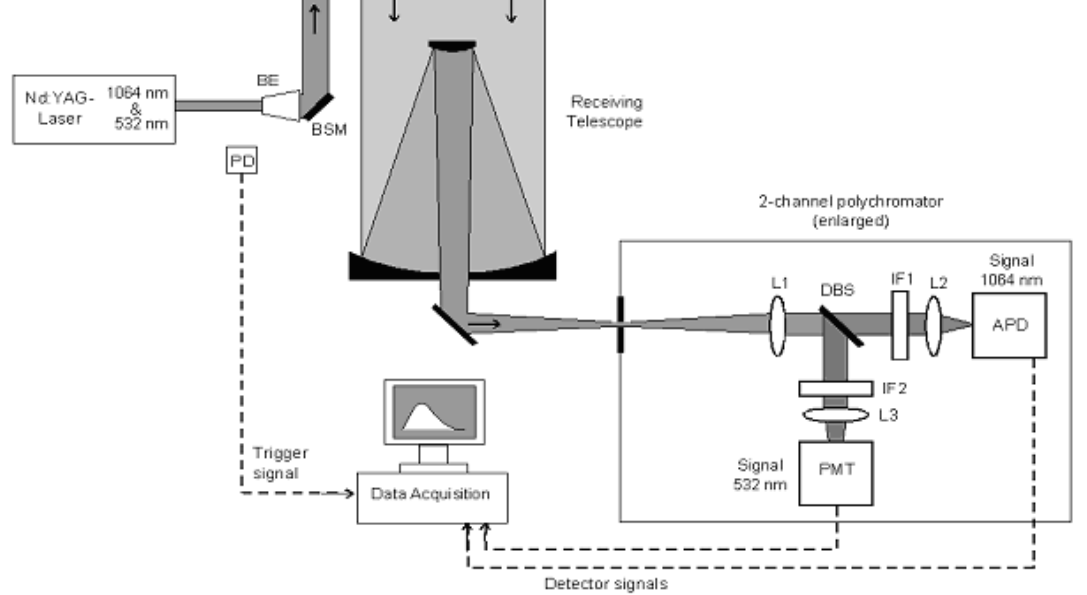
Fig. 1. Scheme of the elastic backscatter lidar of UHOH. APD: Avalanche photodiode, BE: Beam expander, BSM: Beam steering mirror, DBS: Dichroic beam splitter, IF1–IF2: Interference filters, L1–L3: Lenses, PMT: Photomultiplier tube, PD: Photodiode.